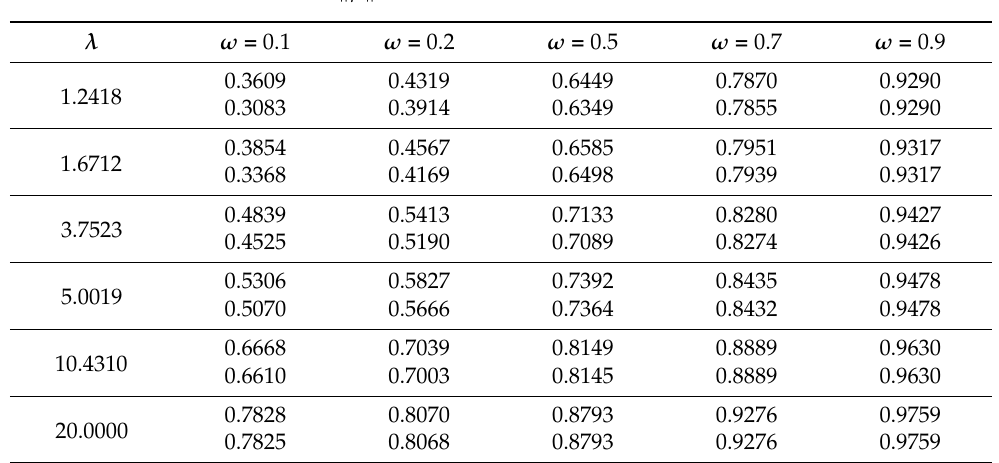
R ω ( T J . S ( (cid:107) Y (cid:107) 2 ) , µ ) R ω ( T J . S + ( (cid:107) Y (cid:107) 2 ) , µ ) and for d = 10 and ω = 0.1, 0.2, 0.5, R ω ( T 0 , µ ) R ω ( T 0 , µ )